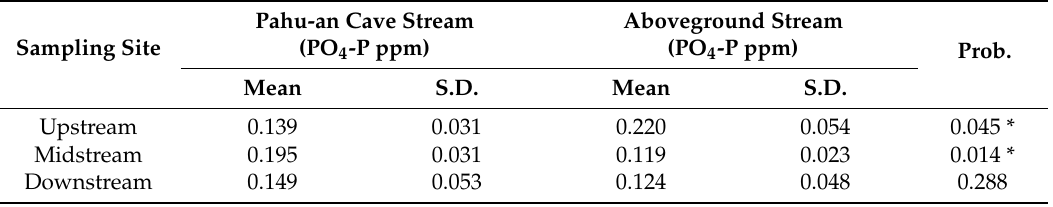
Table 2. Phosphate content